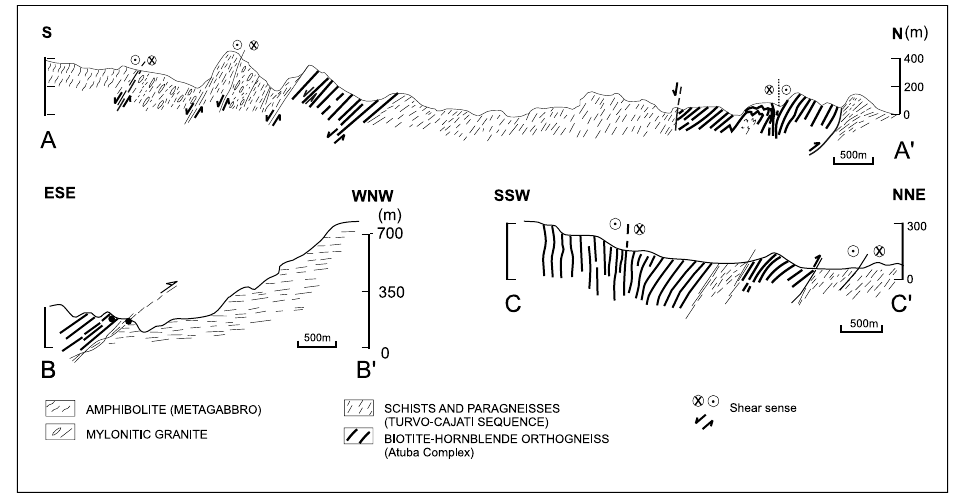
Fig. 3 – Structural cross-sections of the study area: (A’-A) N-S section; (B-B’) E-W section; (C-C’) SSW-NNE section. For location see Figure